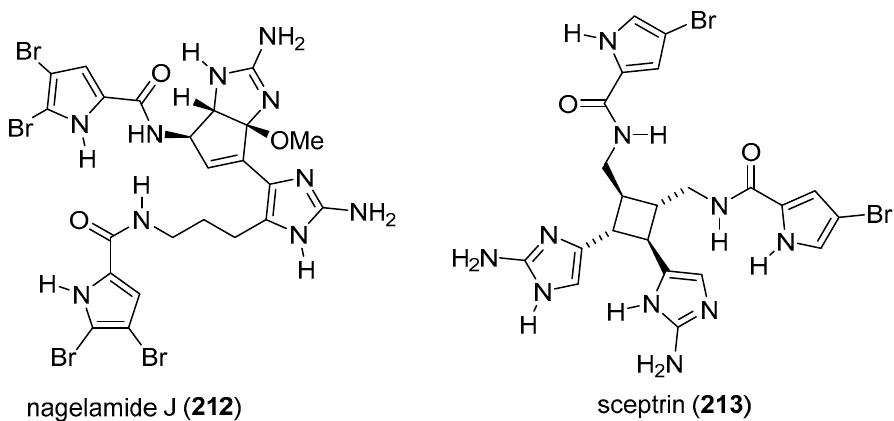
Figure 9. Structures of nagelamide J ( 212 ) and sceptrin ( 213 ).